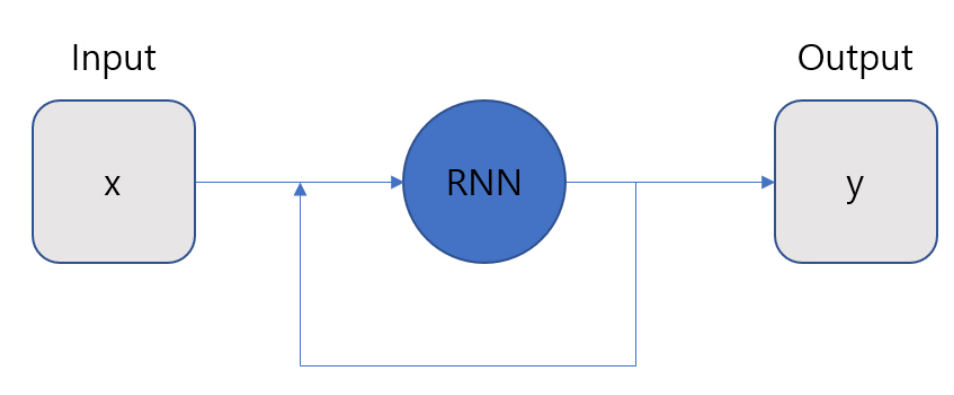
Figure 4. Unfolded structure of recurrent neural